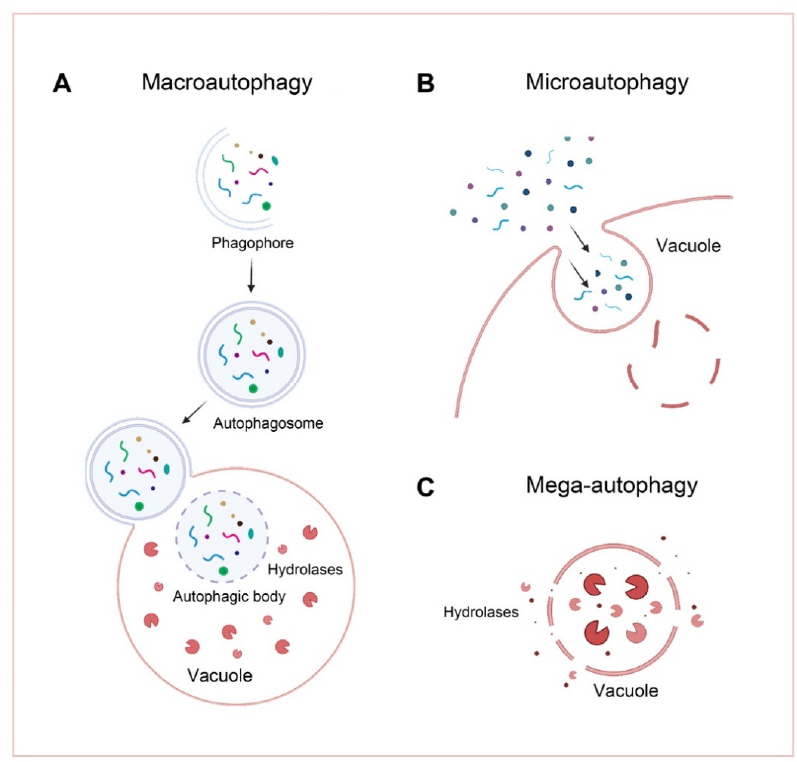
Figure 1. Schematic of the three types of plant autophagy. ( A ) In macroautophagy, a cup-shaped phagophore is formed and closes into double-membrane autophagosomes while wrapping the cellular substances. The autophagosome is then delivered to the vacuole, fused with the tonoplast, and degraded in the vacuolar lumen. ( B ) In microautophagy, intracellular material directly enters the vacuole by vacuolar endocytosis and is degraded. ( C ) During mega-autophagy, the tonoplast permeabilizes and ruptures, releasing a large number of hydrolases into the cytoplasm, resulting in indiscriminate degradation of cytoplasmic materials.